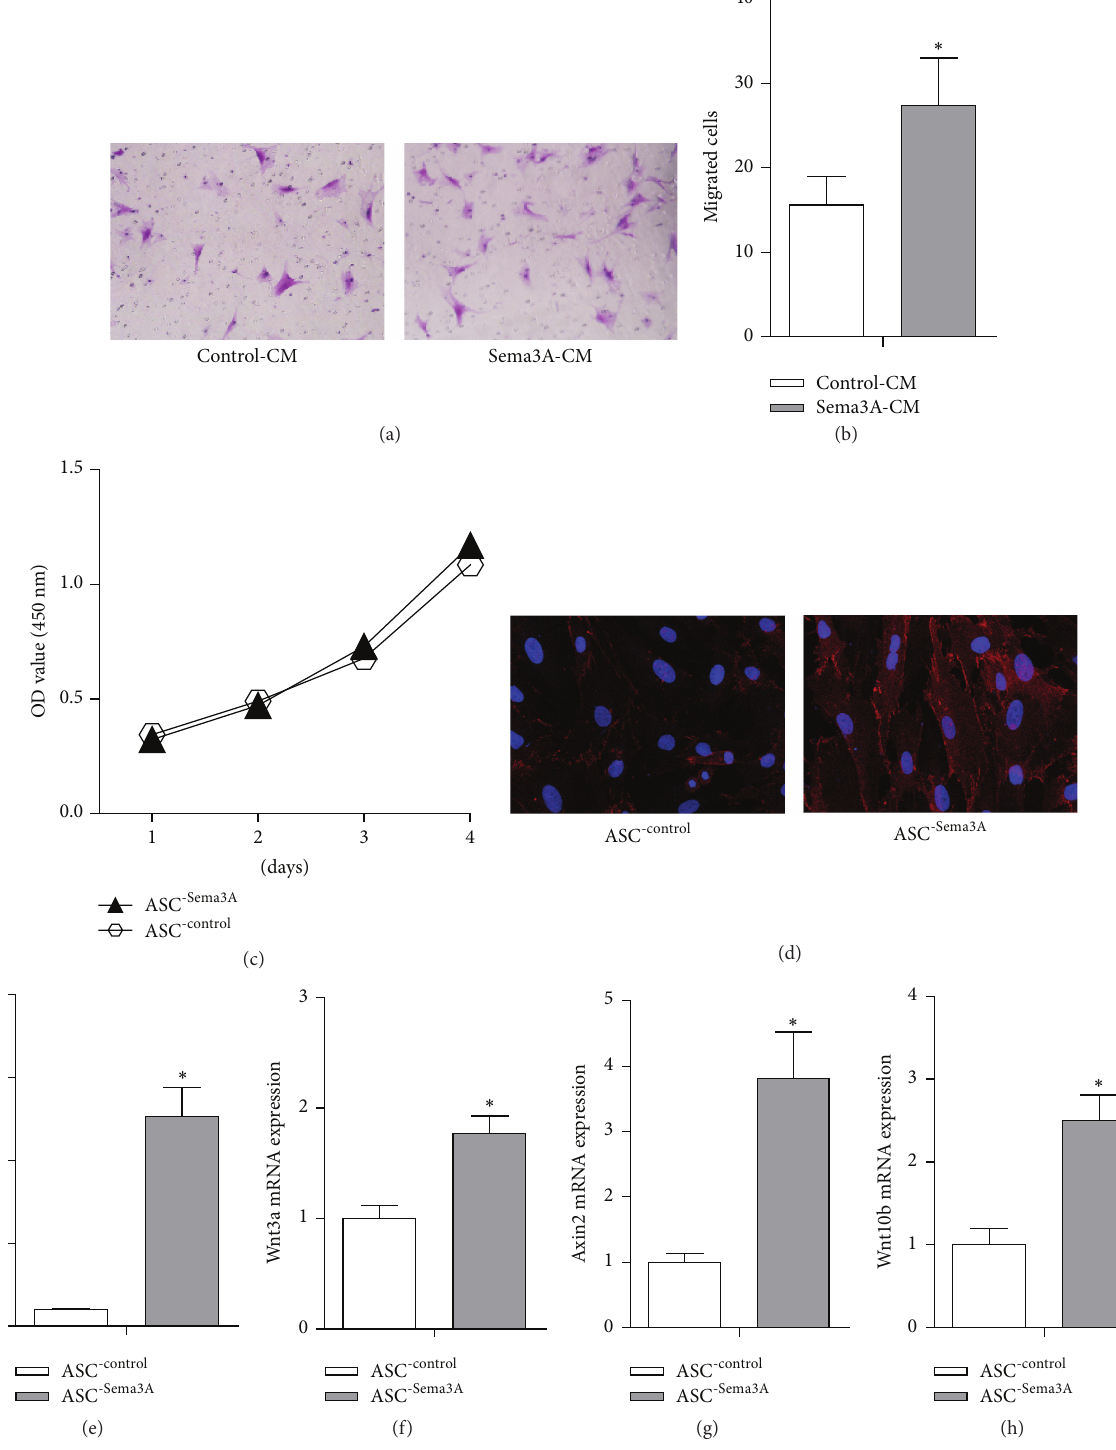
Figure 7: Sema3A significantly activates Wnt/ 𝛽 -catenin pathway in ASCs. (a) Conditioned medium from the Sema3A infected cells increased the migrated cells number. (b) Quantitative analysis of migrated cells in Figure 7(a). (c) No significant differences were found in the proliferation rate between ASC - control and ASC - Sema 3 A . (d) Immunofluorescence staining of 𝛽 -catenin in control and Sema3A overexpressed ASCs, and Sema3A induced nuclear translocation of 𝛽 -catenin. (e) Sema3A overexpression significantly increased the Topflash/Fopflash ratio, indicating activation of Wnt pathway. (f, g, and h) The mRNA expression analysis of the Wnt pathway related genes and downstream transcriptional targets of 𝛽 -catenin in control and Sema3A overexpressed ASCs. Mean ± SD, 𝑛 = 3 , and ∗ 𝑝 < 0.05 . CM, conditioned